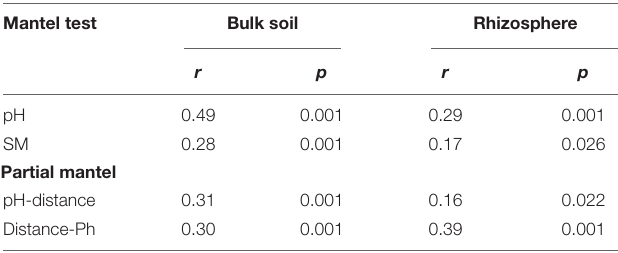
TABLE 1 | Mantel test results showing relationships between soil pH, soil moisture (SM), and eukaryotic community composition in rhizosphere and bulk